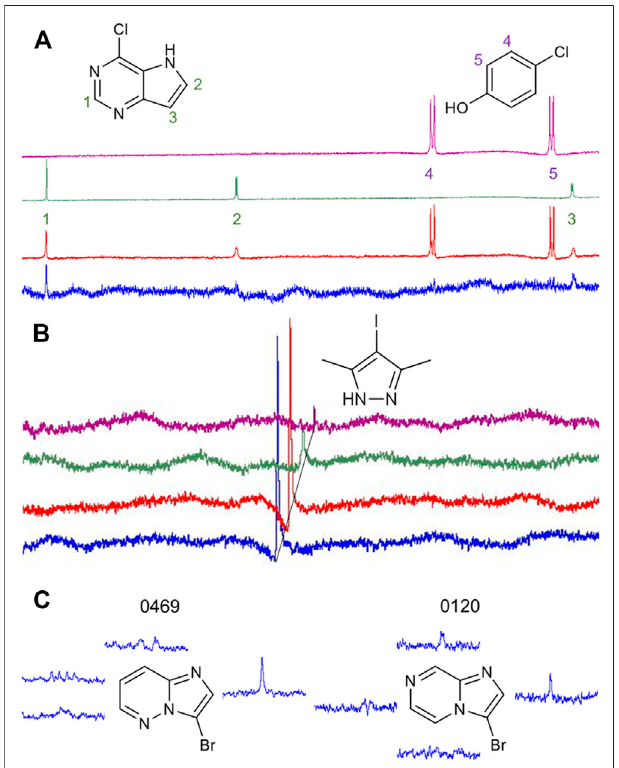
FIGURE 2 | (A) : Comparison of the reference 1 H NMR spectrum of the mixture of fragments 9595 and 4485 (red) with the spectrum of 9595 (green), 4485 (purple), and the difference spectrum with AAK1 (blue). While two of three protons of 9595 are visible in the difference spectrum, the spin system of 4485 (Signal 4 and 5) is obscured by the noise. (B) : Comparison of difference spectra of the same fragment mixture with AAK1 (blue), CAMK1G (red), IDO1 (green), and DOT1L (purple). All spectra show the same overlapping peak (CH 3 -signal of 0459), depicted with a 0.02 ppm offset betweenthespectraforimprovedvisibility. (C) :Twoexamplesoffragmenthits binding to CAMK1G. NMR peaks were clipped and arranged in proximity to the correspondingprotons. The fragments share similarity in structure, as well as in the spectrum. Only the singlet signal of the proton next to the halogen receives enough saturation to facilitate the classi fi cation of 0469 and 0120 as fragment hits. The vicinity of halogens to the strongest STD-signal was one criterion for fragment prioritization, because it indicates that the binding motif involving the halogen is more likely to engage in interactions with the protein binding